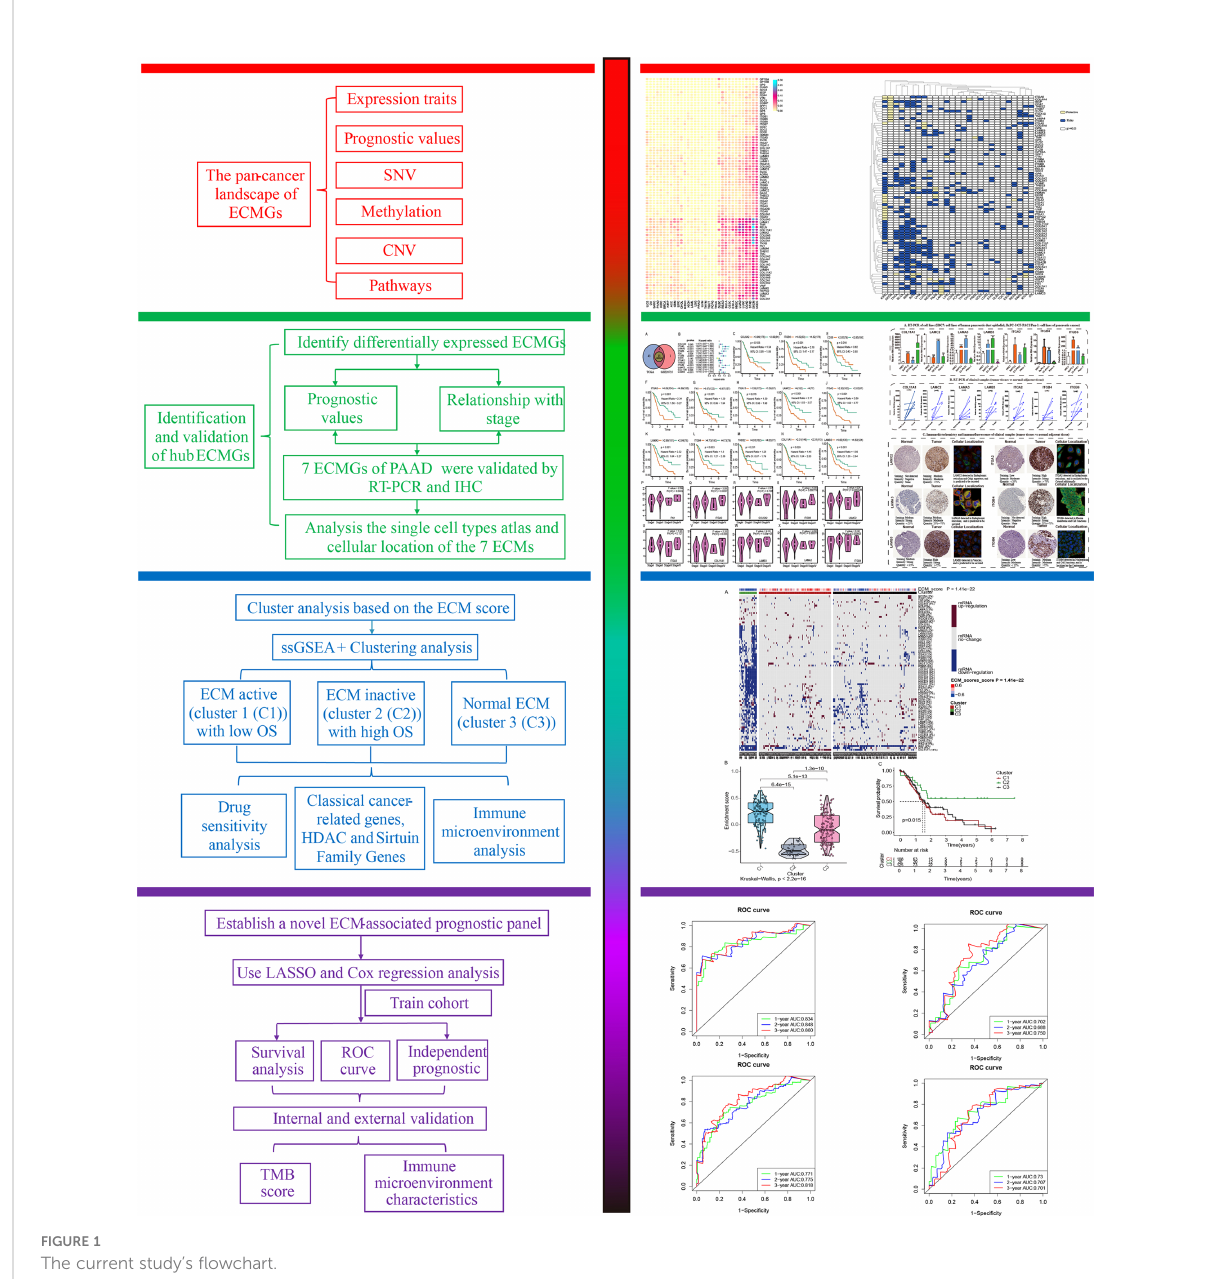
FIGURE 1 The current study ’ s fl